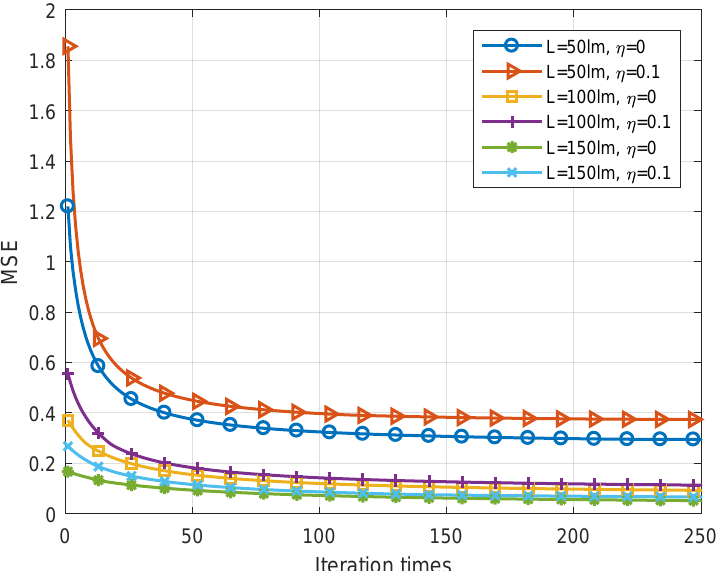
Figure 4. Convergence performance of the iterative algorithm with different luminous fluxes and interference ratios η when CCT = 5000